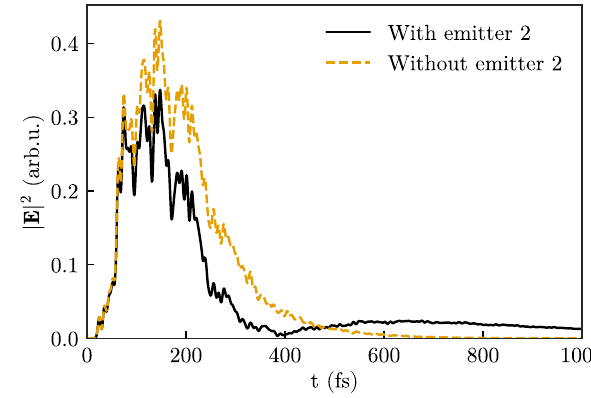
Figure 3: Population of emitters 1 (black line) and 2 (orange line) for the Wigner – Weisskopf problem, with emitter 1 initially excited. The blue dashed line shows the dynamics of emitter 1 if emitter 2 is not present.